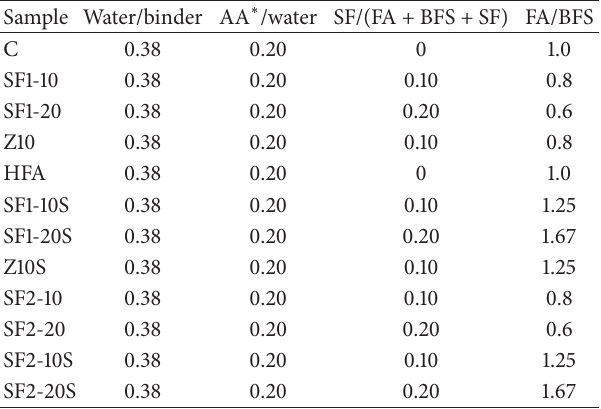
Table 2: Mix proportion of fly ash-slag geopolymer paste.